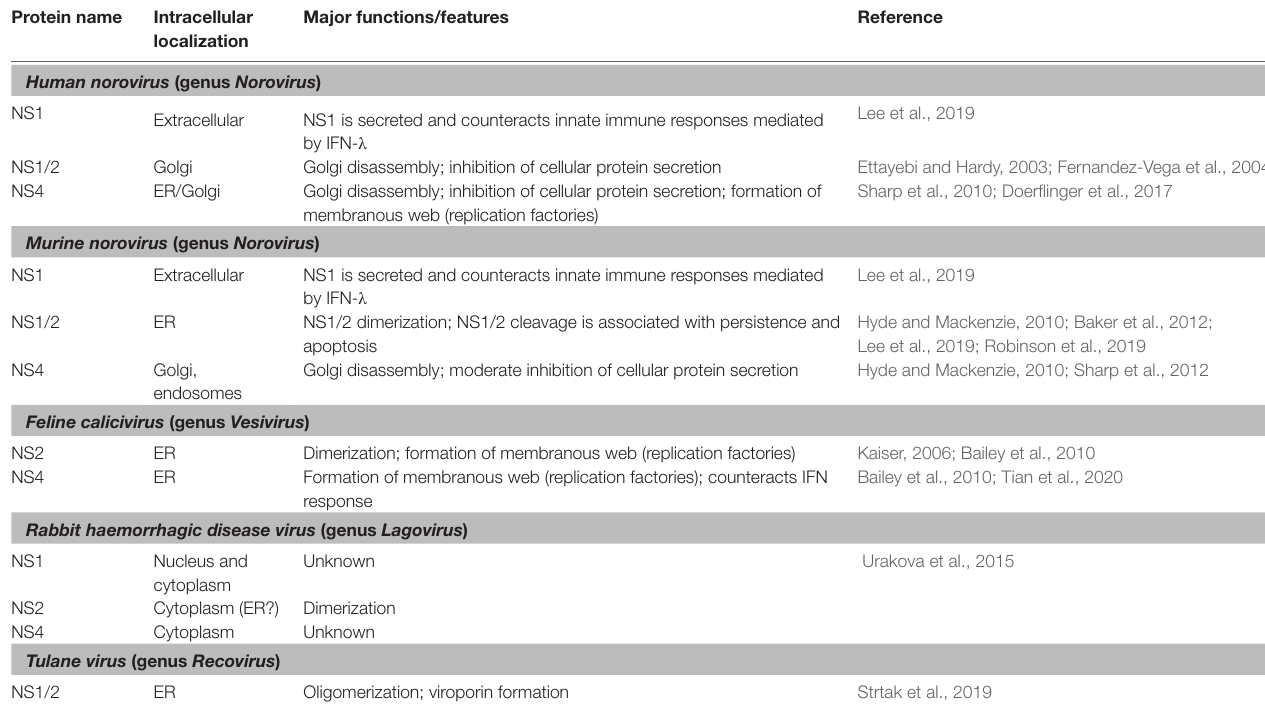
TABLE 1 | Cellular localization and functional properties of calicivirus non-structural